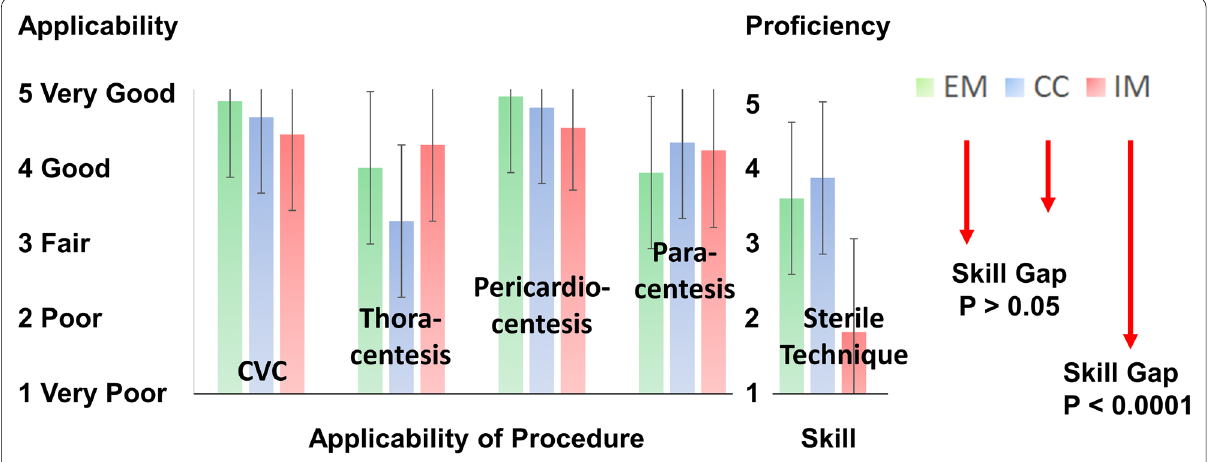
Fig. 1 Applicability of four procedural skills, physicians’ proficiency in the sterile technique required to perform ultrasound-guided procedures, and the skill gaps. The perceived applicability of each procedure to the practice of each specialty was assessed using a Likert scale (1 very poor, 2 poor, 3 fair, 4 good, 5 very good). The proficiency in the sterile technique required to perform ultrasound-guided was self-reported on the same Likert scale. Data stratified by specialty are presented as mean standard deviation. The skill gap is calculated as the difference between the average ± applicability and the proficiency. The data from which this figure is derived are also presented in Table 3. CC critical care, EM emergency medicine,